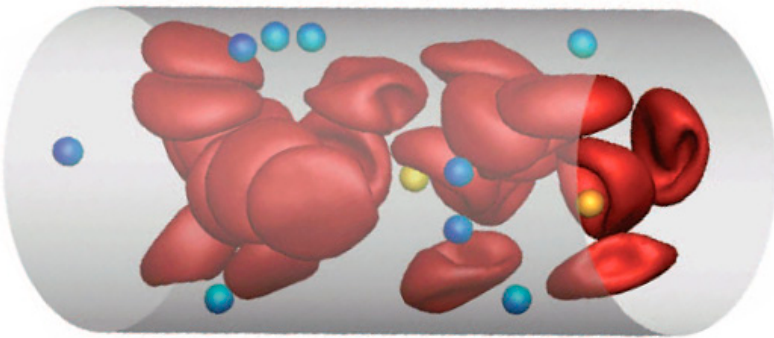
Figure 2. Three-dimensional simulation of blood flow in a tube with several spherical drug carriers.